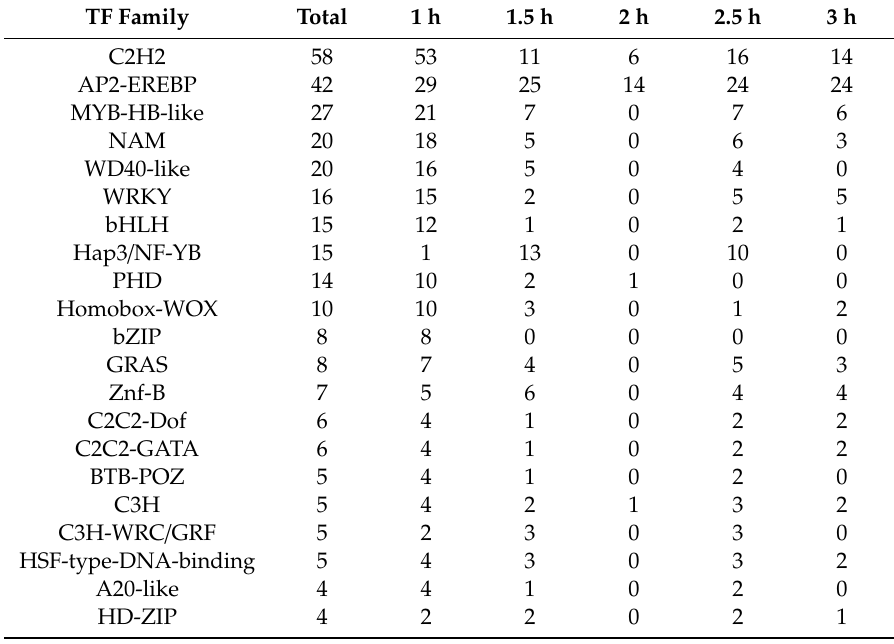
Table 2. Di ff erentially expressed transcription factors (TFs) under di ff erent low-temperature stress time